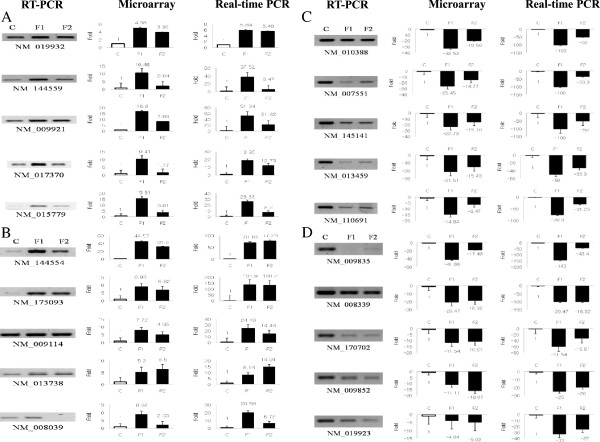
Validation of independent microarray data using RT-PCR and qRT-PCR. A. Upregulated genes in tg mice included 5 selected genes involved in defense and immunity. B. Upregulated genes involved in signal transduction in tg mice. C. Downregulated genes related to defense and immunity proteins in tg mice. D. Downregulated genes associated with receptors in tg mice. The relative expression levels were analyzed by RT-PCR (left) and real-time PCR (right). Columns and bars represent the means and standard error (n = 3) respectively. tg, transgenic.